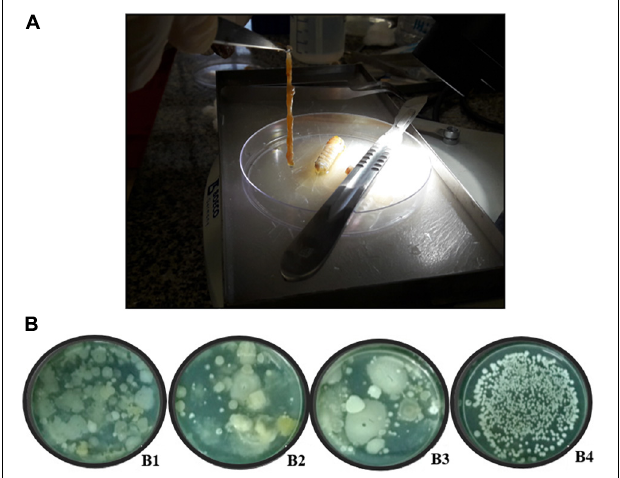
FIGURE 1 | Digestive tract of giant borer ( Telchin licus licus ) and the diversity of colonies in solid BHI medium used for the isolation of bacteria. (A) The digestive tract being removed with the aid of forceps; (B) (B1) Bacteria obtained from the central region of the internodes, (B2) apoplast fluid, (B3) sugarcane roots, and (B4) digestive tract of the giant